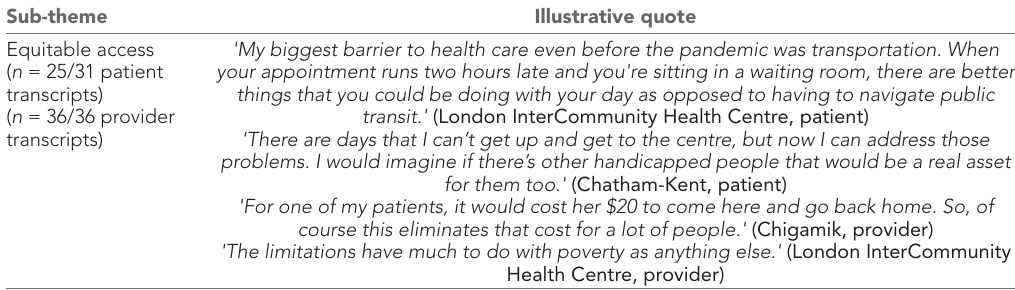
Table 2 Quadruple aim 1: Improving health of populations Sub-